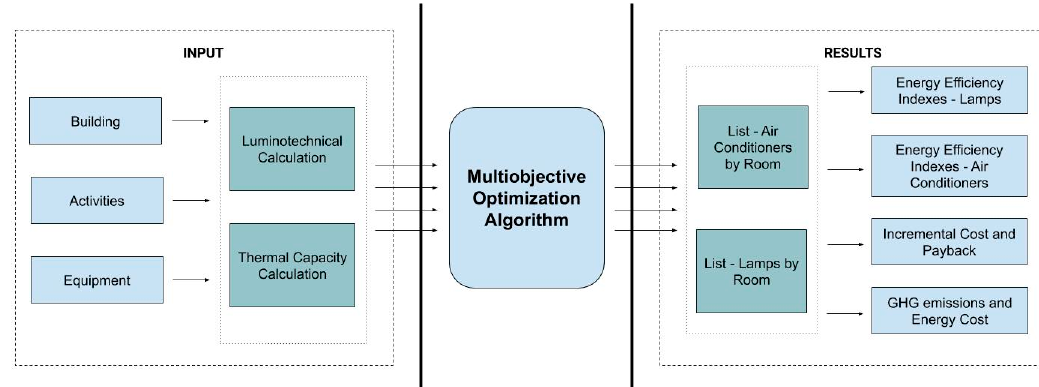
Figure 2. Proposed methodology for the optimization multi-objective of buildings air conditioning and lighting systems.